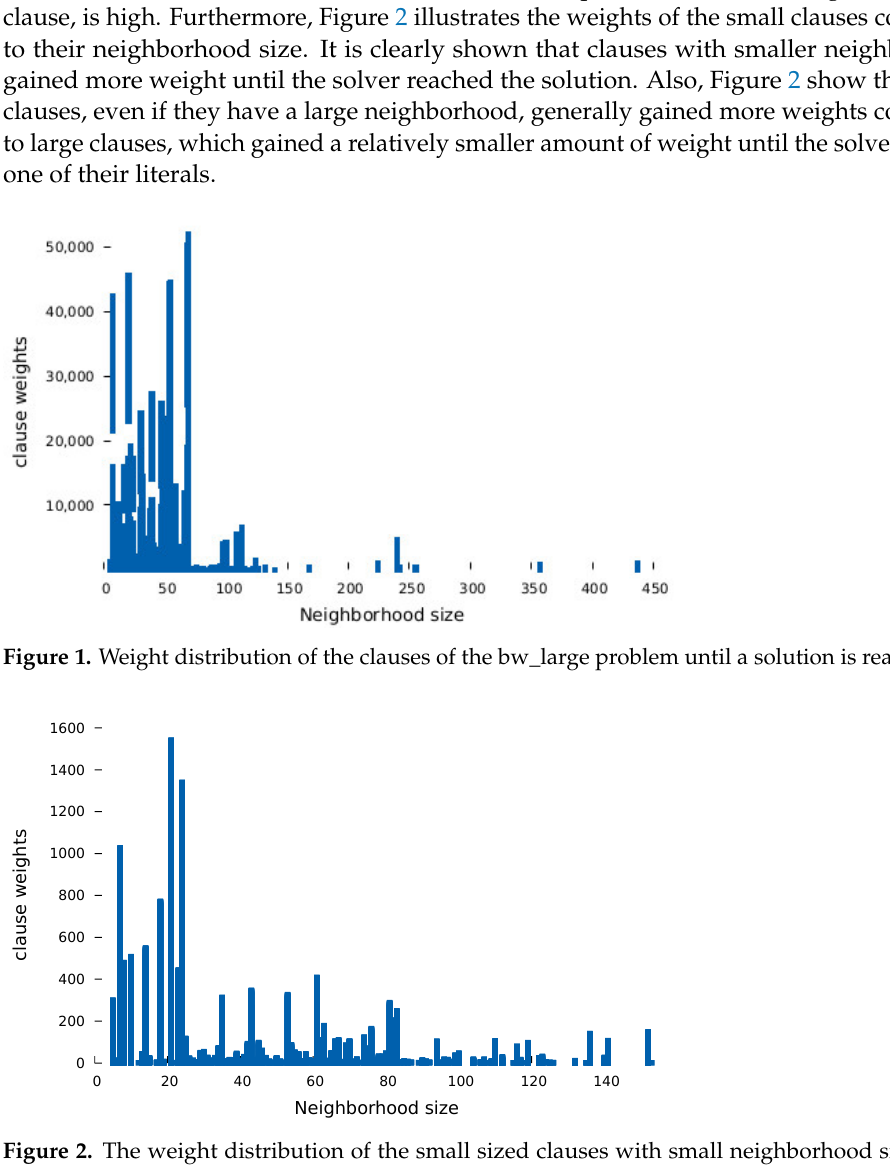
Figure 2. The weight distribution of the small sized clauses with small neighborhood size of the bw_large